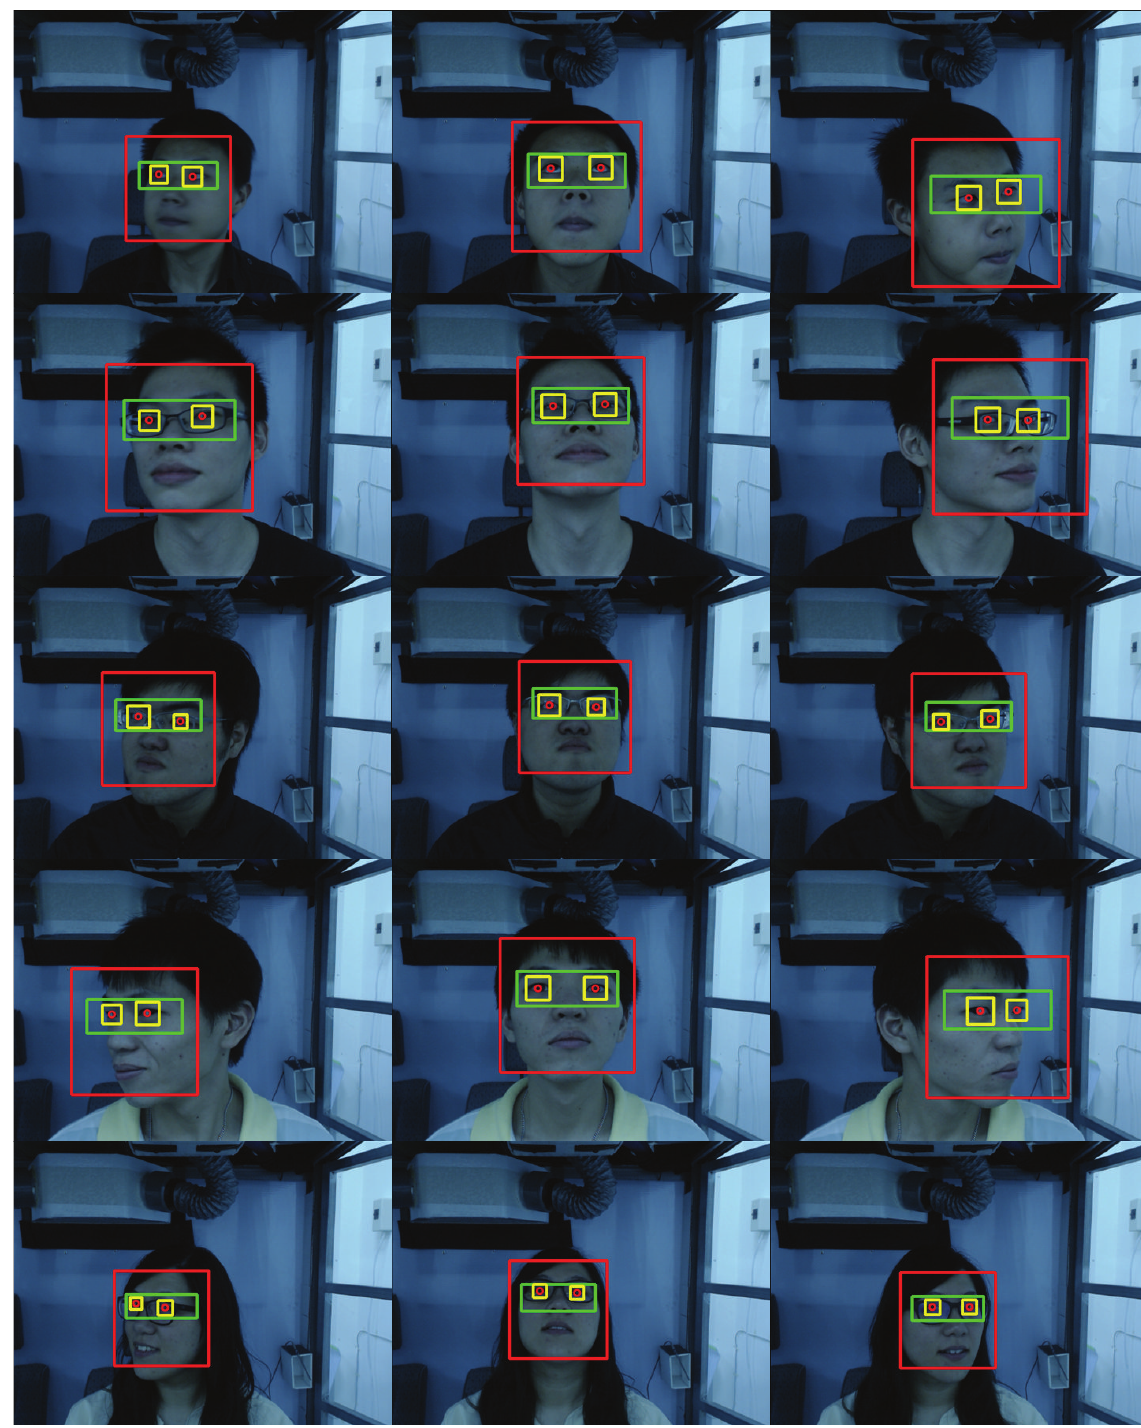
Figure 18: The result of evaluate the proposed system capability in different